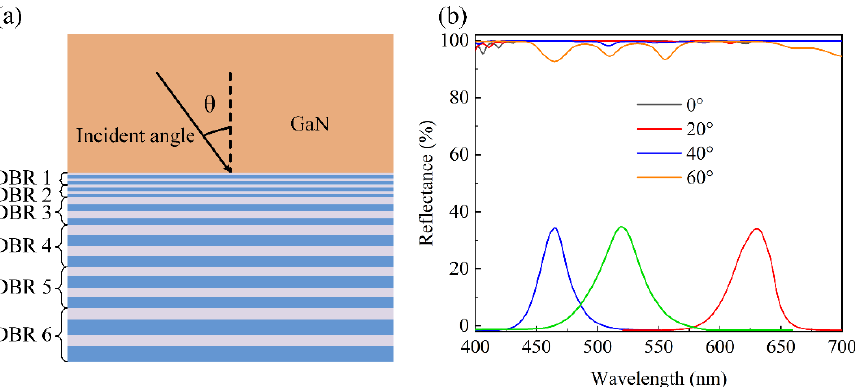
Figure 5. ( a ) Schematic illustration of the WRA-DBR structure. ( b ) Reflectance spectra of the WRA- DBR as a function of incident angle. Table 1. Optical parameters for each layer of AlGaInP-based red micro-LED and GaN-based blue and green micro-LEDs used in the FDTD